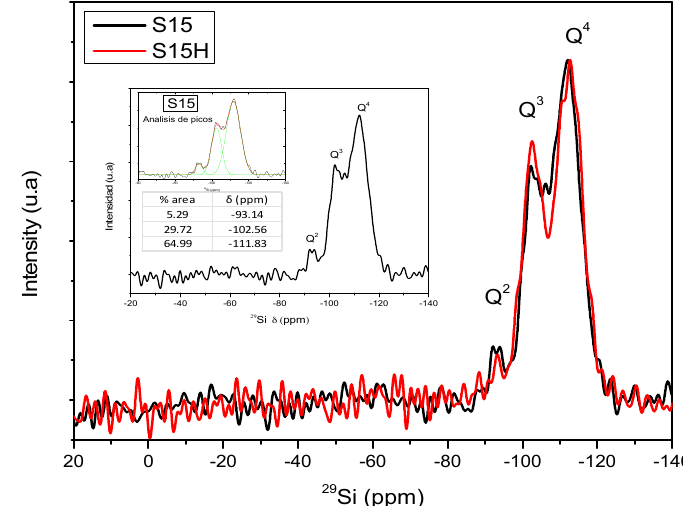
Figure 11. 29 Si Nuclear Magnetic Resonance (NMR) spectra (High Power Decoupling) for the S15 and S15H samples. The figure inset exemplifies a peak analysis performed after deconvolution of the set of different signals obtained through 29 Si NMR analysis on the S15 solid.